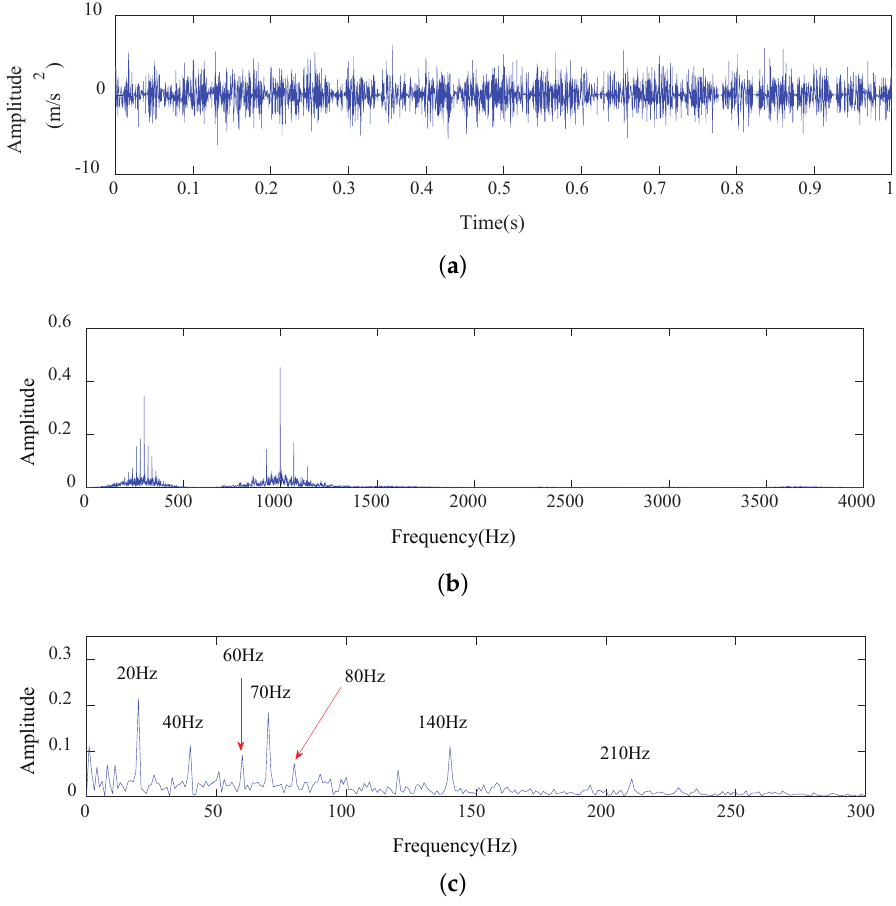
Figure 7. Results of the proposed WOGS algorithm: ( a ) Time domain waveform. ( b ) Frequency spectrum. ( c ) Envelope